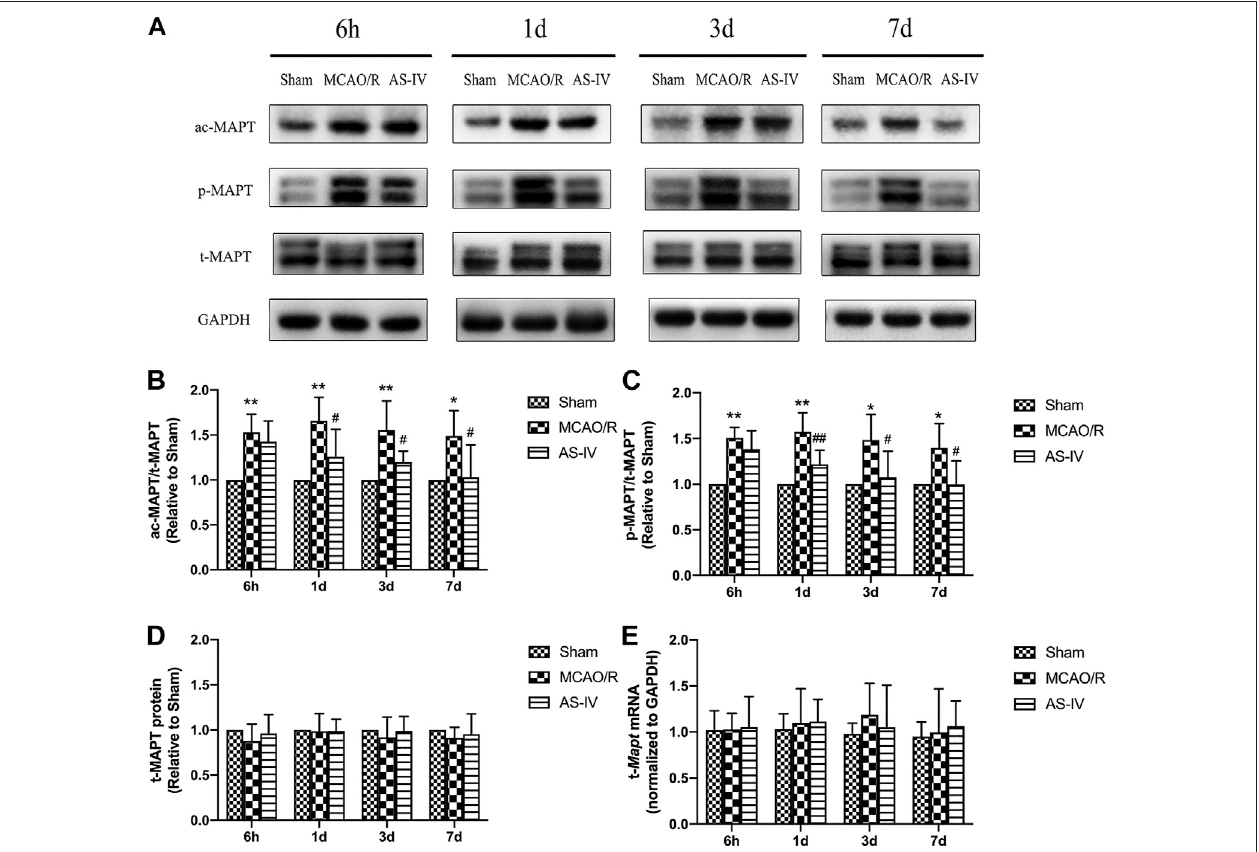
FIGURE 5 | The expressions of total MAPT (t-MAPT), acetylized MAPT (ac-MAPT), and phosphorylated MAPT ( p -MAPT) in Sham group, MCAO/R group, and AS-IV group at 6 h, 1 d, 3 d, and 7 days after CIR injury (mean ± SD, n (cid:1) 6). (A) The results from the Western Blot. (B) Quantitative analysis for the protein level of ac-MAPT. (C) Quantitative analysis for the protein level of p -MAPT (D) Quantitative analysis for the protein level of t-MAPT. (E) Quantitative analysis for the mRNA level of t-Mapt. * p < 0.05, ** p < 0.01, compared with the Sham group; # p < 0.05, ## p < 0.01, compared with the MCAO/R group.